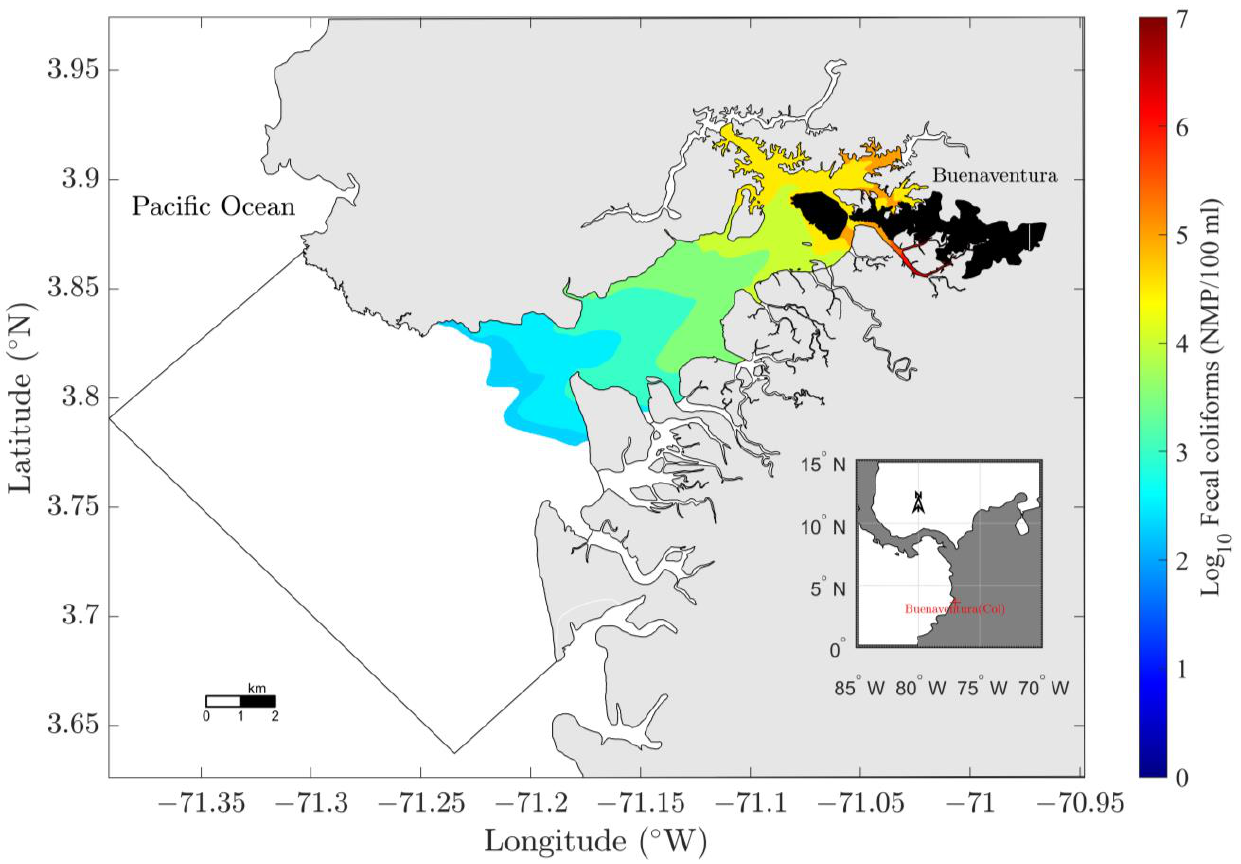
Figure 11. Spatial distribution of the maximum concentration of FC in the Bay of Buenaventura in the current scenario.